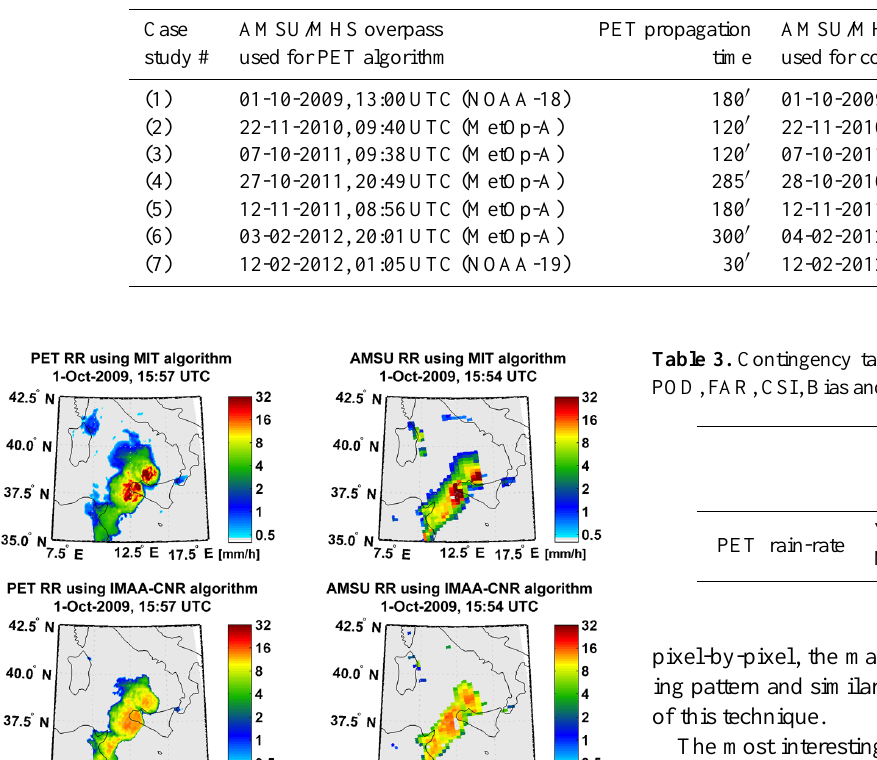
Table 2. List of case studies selected for PET performance evaluations.